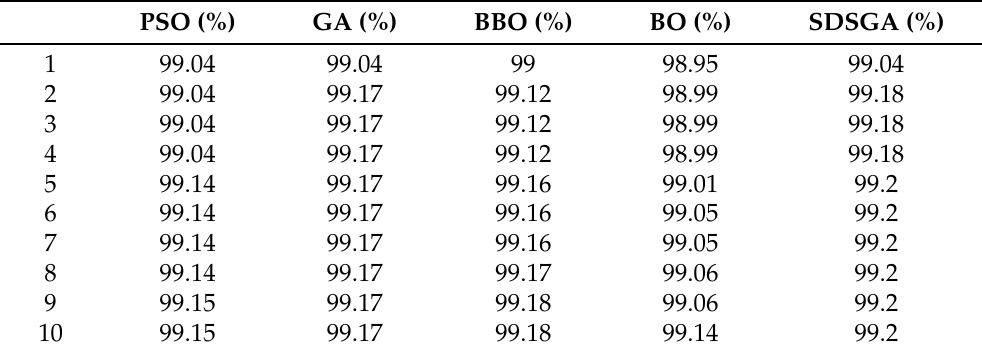
Table 3. Result of optimizing the CNN model on the MNIST dataset. The data have been prepared to show the best accuracy so